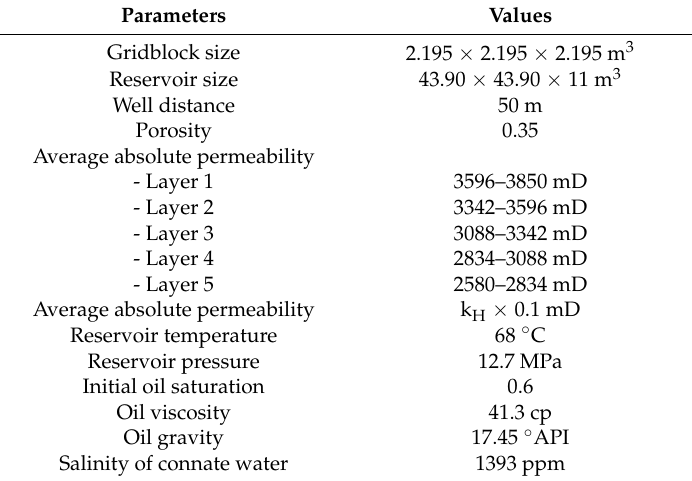
Table 1. Reservoir properties for simulation as referenced from the Gudong oil